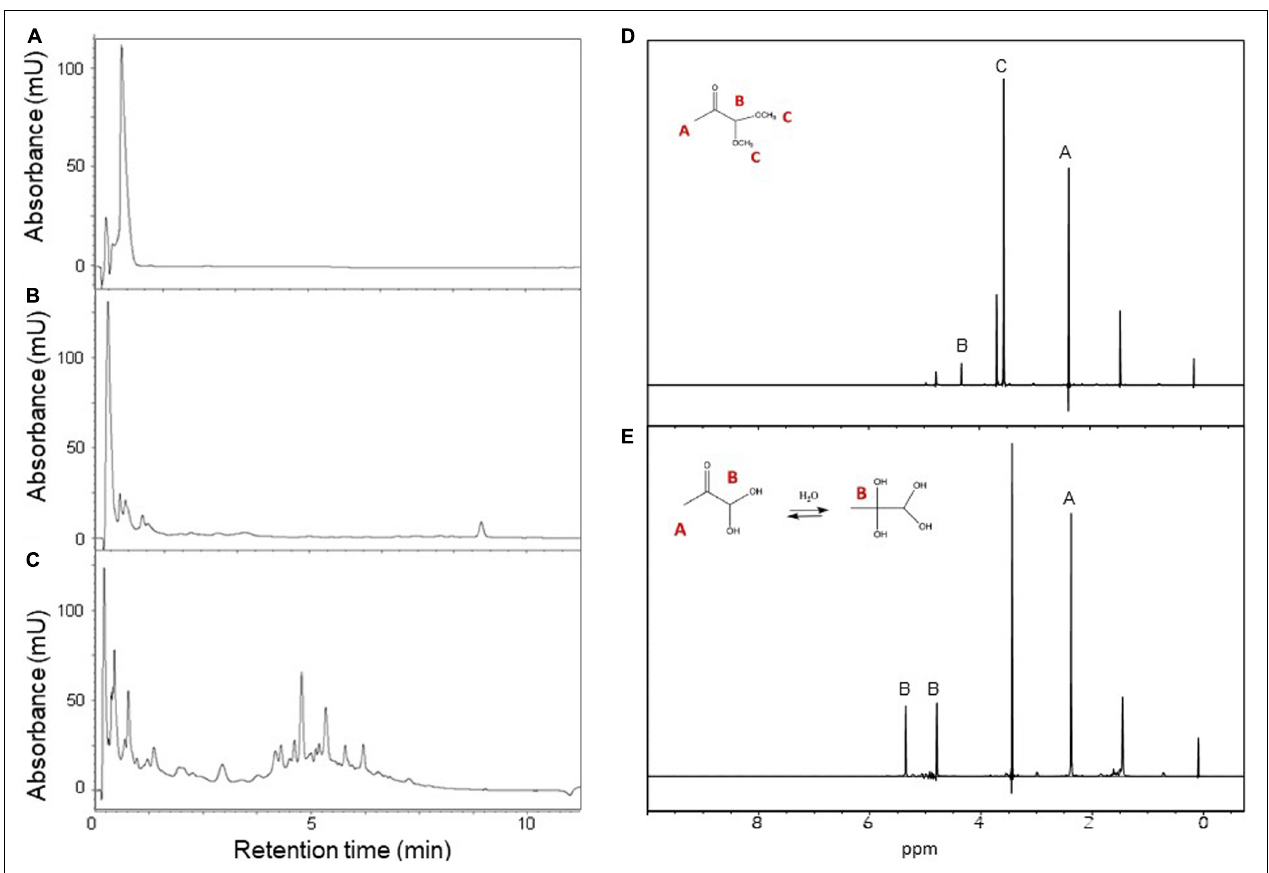
FIGURE 1 | Preparation of MGO starting from pyruvaldehyde dimethyl acetal. Left panel: HPLC-UV analysis of pyruvaldehyde dimethyl acetal hydrolysis products. The reaction mixture was analyzed at the beginning of the reaction (A) and after 15 (B) and 60 min (C) of incubation. Right panel: 1 H NMR spectra of pyruvaldehyde dimethyl acetal and its product MGO with assignment and their chemical structure. (D) Time zero of the reaction, δ : 2.18 (s, 3H, CH3), 3.40 (s, 3H, CH3), 4.44 (s, 1H CH). (E) Reaction completed, δ : 2.38 (s, 3H, CH3), 5.40 (s, 1H, CH), 4.82 (s, 1H, CH). The spectra were recorded at 25 ◦ C on a Bruker AVANCE spectrometer operating at 800